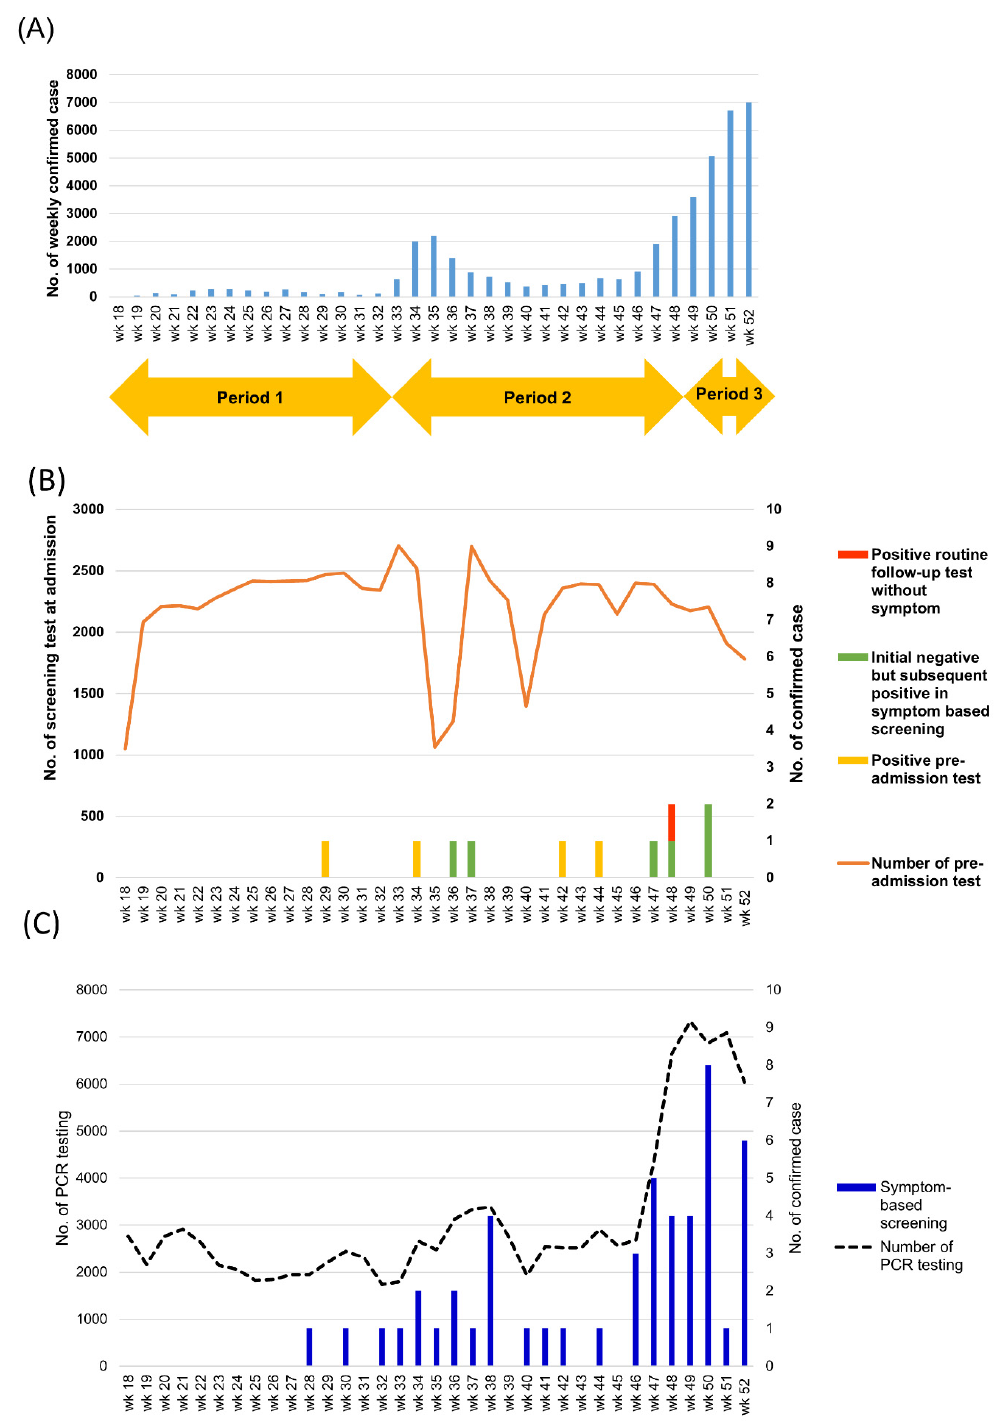
Figure 1. Trends of domestic cases of COVID-19 in South Korea and pre-admission screening tests at the Asan Medical Center. ( A ) Number of weekly domestic cases in South Korea between week 18 and week 52 of the year 2020. Period 1: new daily domestic cases < 1 per million inhabitants; period 2: new daily domestic cases: 1–8.3 per million inhabitants; period 3: new daily domestic case: 10.3–20 per million inhabitants. ( B ) Number of pre-admission screening tests (orange line) and the number of cases with positive results (yellow bars) and cases with initially negative results in pre-admission screening test, subsequent positive results in symptom-based screening (green bars), and universal follow-up testing (red bar) are shown. ( C ) Number of tests for patients with symptoms or epidemiologic link (dotted black line) and the number of cases with positive results are